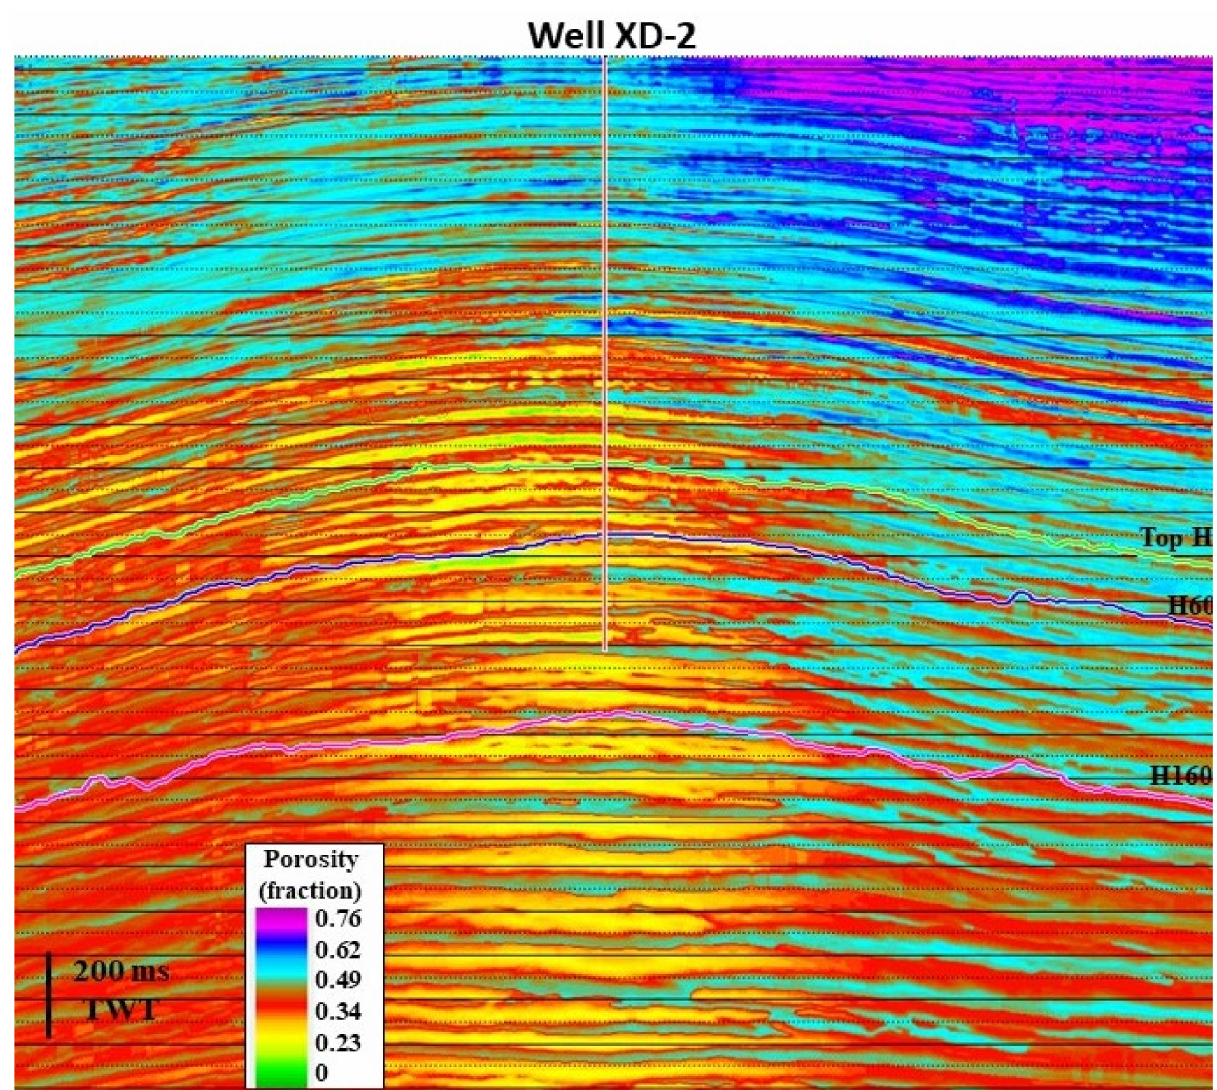
Figure 25. ANN predicted porosity crossline section containing Top H, H60, and H160 horizons and XD-2